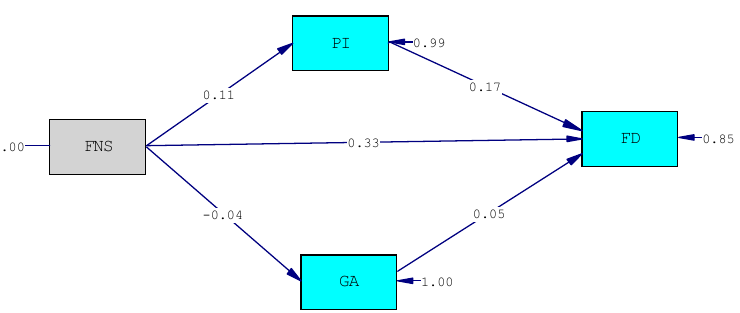
Figure 2. The final model. Chi-Square = 0.01; df = 1; p -value = 0.91495; RMSEA = 0.000. FNS = food neophobia. PI = perceived infectability. GA = germ aversion. FD = food disgust.